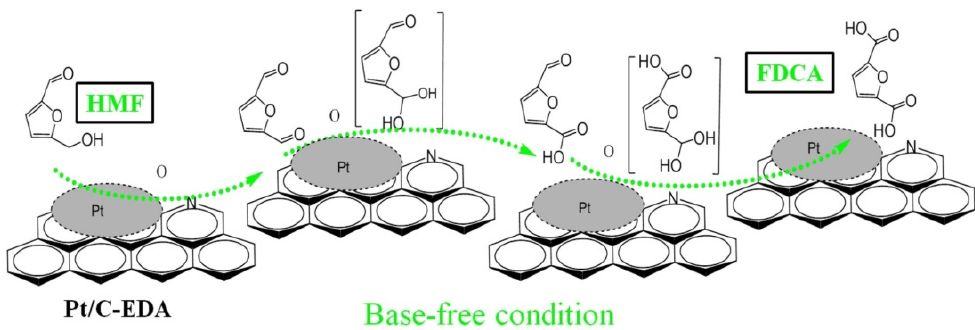
Figure 11. The selective oxidation reaction of 5-hydroxymethylfurfural (HMF) under base-free conditions by Pt/C-EDA-x catalyst. Reprinted with permission from Ref. [38]. Copyright © Elsevier B.V. 2016.